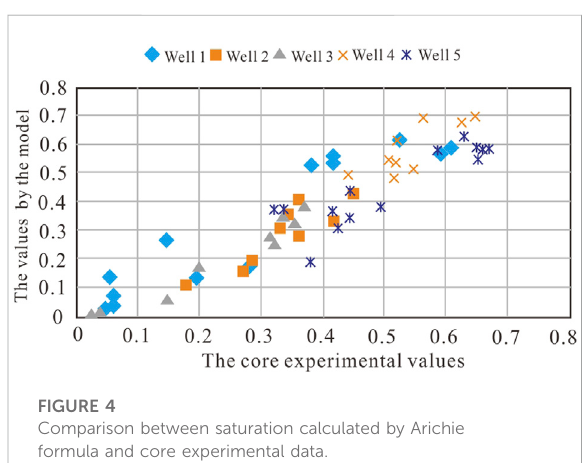
FIGURE 4 Comparison between saturation calculated by Arichie formula and core experimental